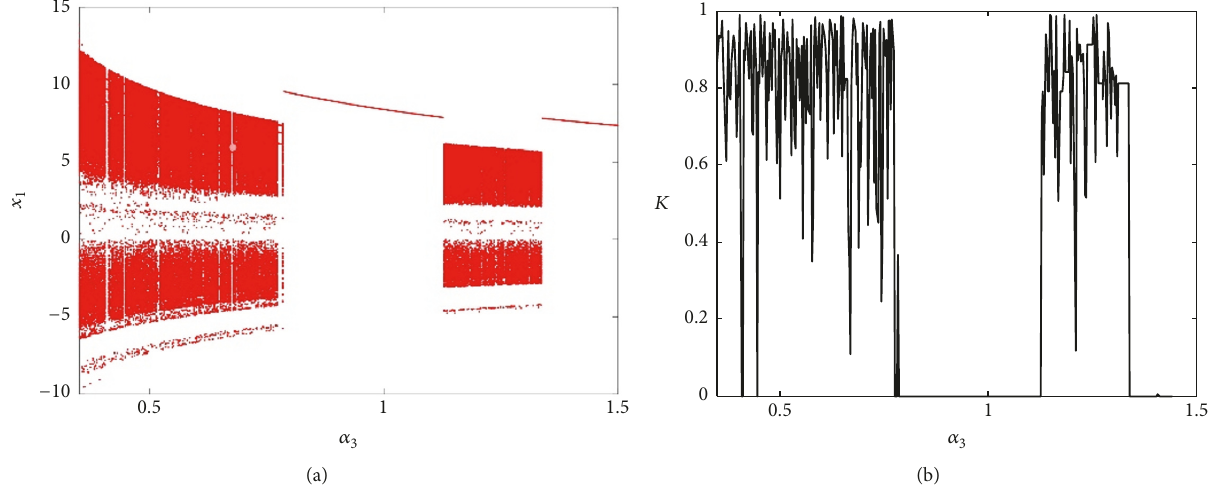
Figure 5: (a) Bifurcation diagram ( 𝛼 3 versus 𝑥 1 ). (b) 𝛼 3 versus 𝐾 .